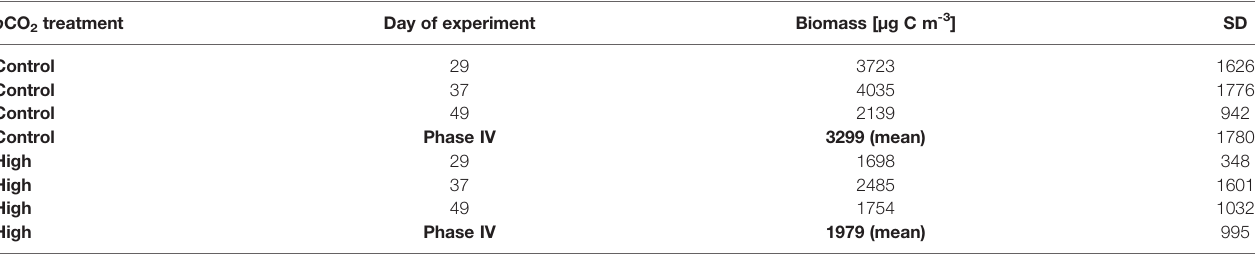
TABLE 1 | Hydrozoa biomass summed (μg C m -3 , 500 μm net samples only) per treatment on speci fi c days of the experiment (DoE) as well as the mean over phase IV of the experiment. p CO 2 treatment